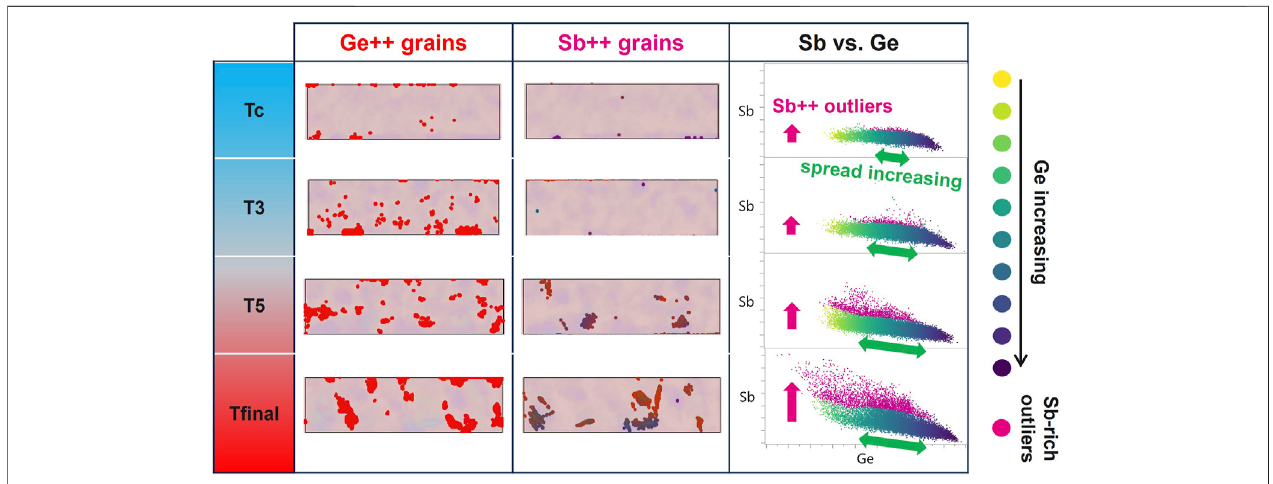
FIGURE 6 | Highlights of PCM stack crystal evolution are as follows: “ Ge++ grains ” column reports signal maps where the highest content of Ge is highlighted; “ Sb++grains ” columnreportssignalmapswhereSb-richoutliersarehighlighted; “ Sbvs.Ge ” columnreportscorrespondingscatterplotwhereSb-richoutliers(reported in “ Sb++ grains ” column)arecoloredinmagenta.Magentaand greenarrows areaguide fortheeyestohighlightoutliers ’ population andspread increasingrespectively.